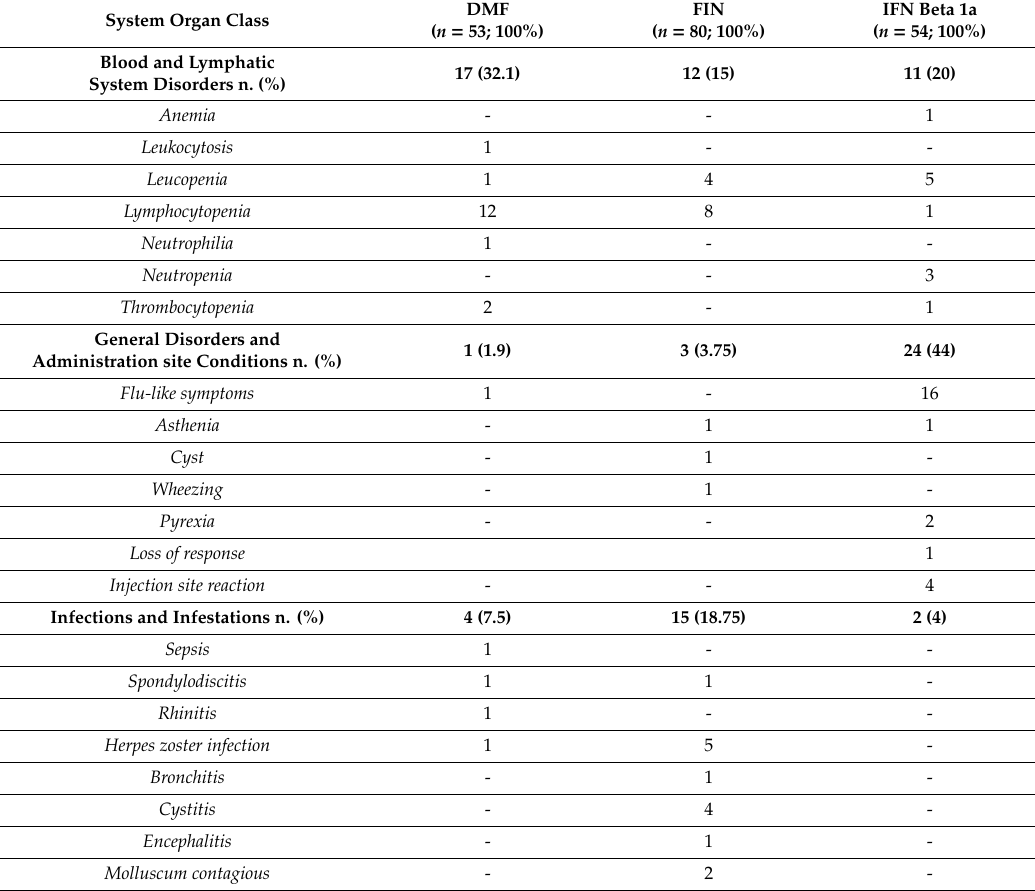
Table 3. Distribution of Adverse Drug Reactions related to dimethyl fumarate, fingolimod and interferon (IFN) beta 1a by System Organ Classes and Preferred